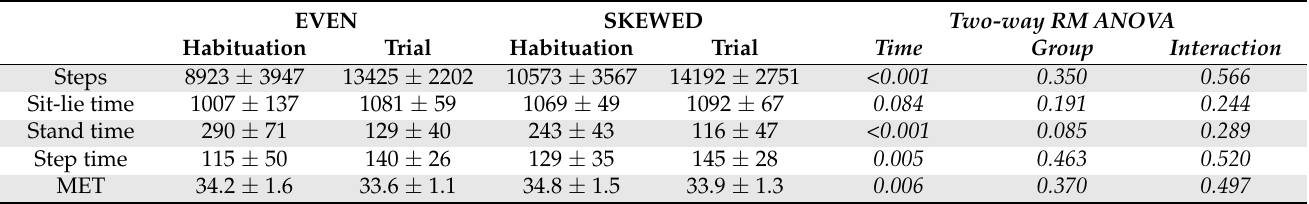
Table 3. Activity monitoring during habituation and trial